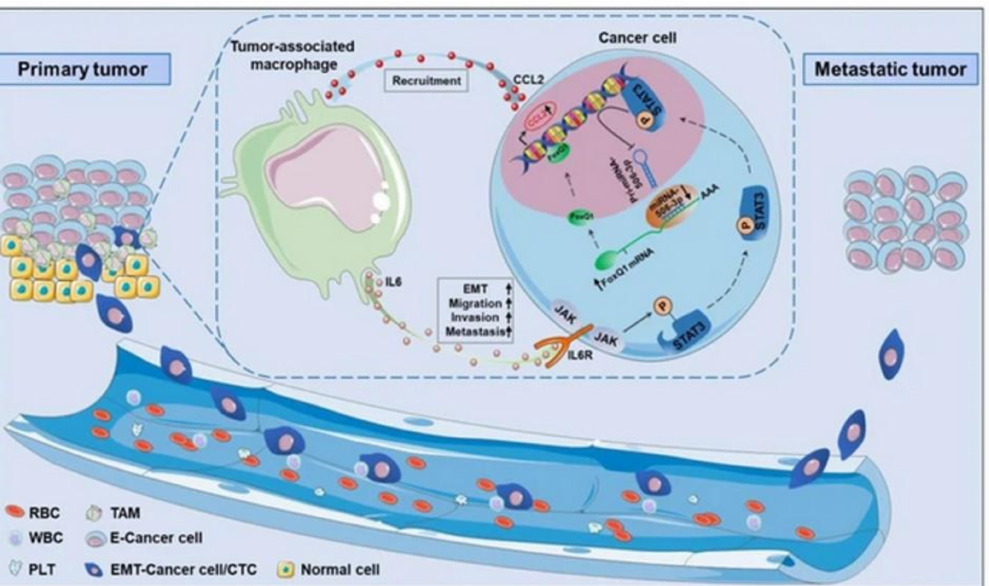
Figure 7. In vitro human cancer models for assessment of tumor biology. Adapted with permission from [123] © Creative Commons Attribution License